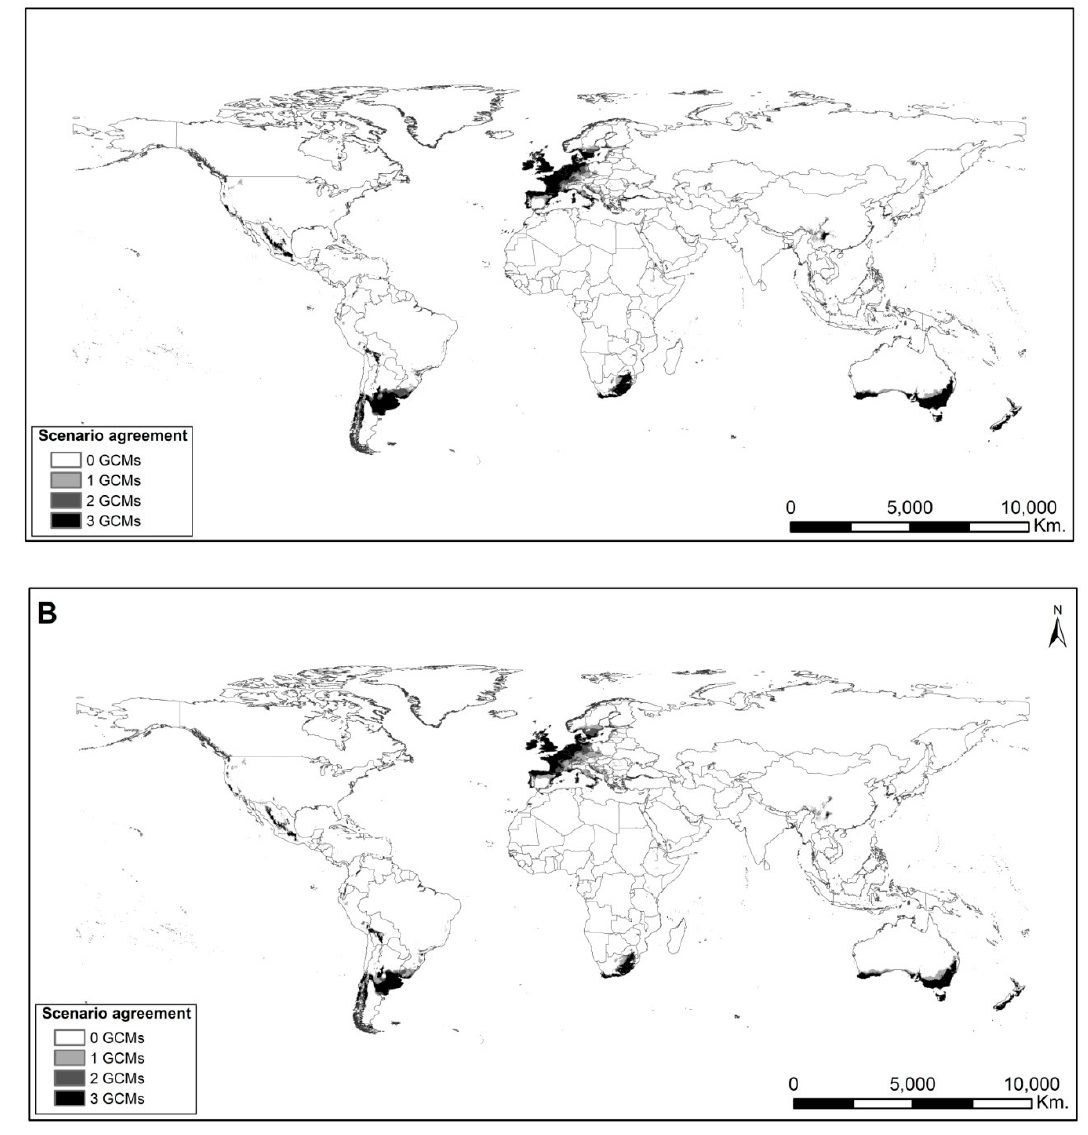
Figure 6. Projected potential distribution of Azolla filiculoides under the optimistic emission scenario (RCP 4.5) and three different GCMs. ( A ) 2050. ( B ) 2080. Darker shades indicate greater overlapping of GCMs.